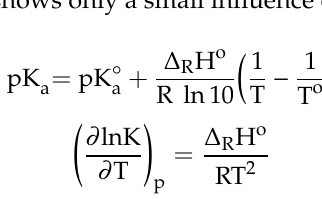
Table 2. Calculated pK a values and radical rate constants of the monoanionic dicarboxylic acids AH − at di ff erent